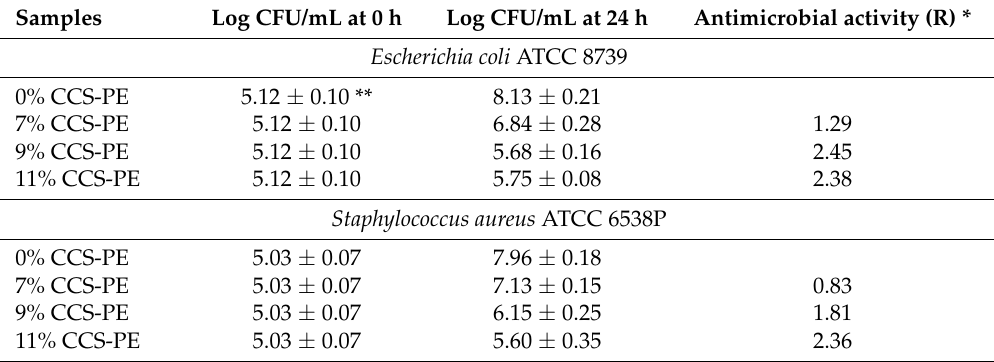
Table 2. Effect of 0%, 7%, 9%, and 11% CCS-PE plastic bags on the antibacterial activity